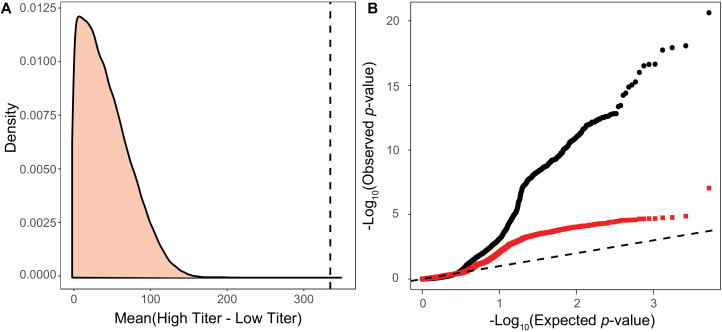
Permutation test for association test for viral virulence.(A) Distribution of mean differences between artificial High type and Low type titers generated by permuting the titer across strains. We binned the Titer of strains by the allele of most significant SNP from the permuted associations and its 10 most strongly linked other sites. Whichever group has the higher titer during in each permutation is taken as the High type. The mean difference between the true High type and Low type is shown as a dashed line on the plot. (B) qqPlot of observed p-values versus the permuted p-values expected under the null expectation of no association. Black circles represent the p-value comparisons including focal haplotype SNPs. Red squares represent p-value comparisons with number of focal SNPs as a covariate, excluding these SNPs from the association study. A one to one correlation is shown as a dashed line.